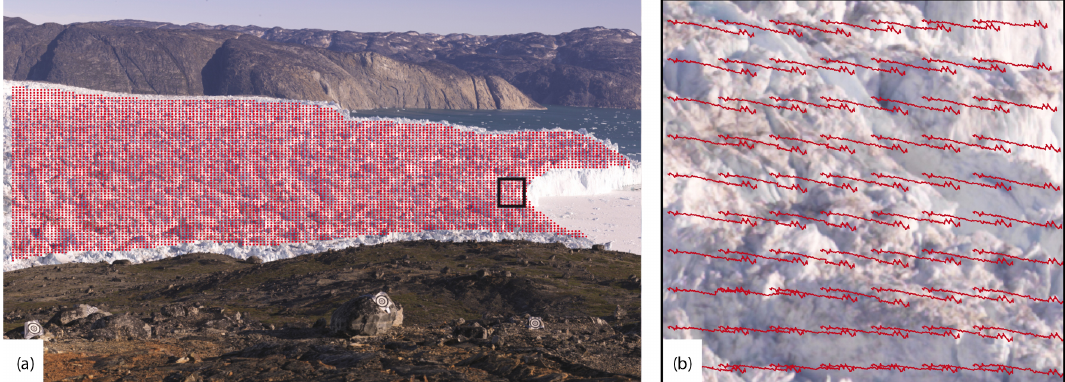
Figure 5. Raster of measurement points on the glacier surface (a) and resulting trajectories obtained from feature tracking (b) . The figure shows the grid of the measuring points (red dots) as a superposition of a sequence image (a) . For the area marked by the black square, the corresponding image section is shown on the right. It is superimposed by the measured trajectories (red lines) for a 24h image sequence (acquisition interval 20min; b